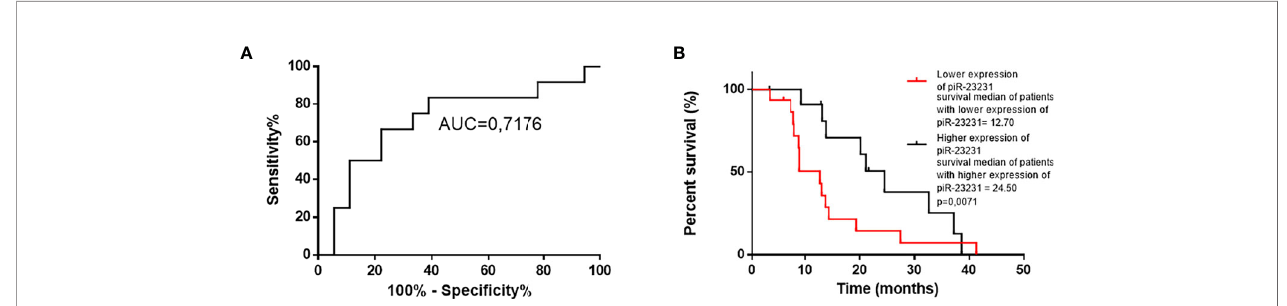
FIGURE 5 | ROC and Kaplan – Meier analysis of piR-23231 on validation cohort of patients. (A) ROC analysis to determine the distinguishing ability of piR-23231 between patients with survival shorter and longer than 15 months. (B) Kaplan – Meier analysis of lower levels of piR-23231 against higher levels ( p =